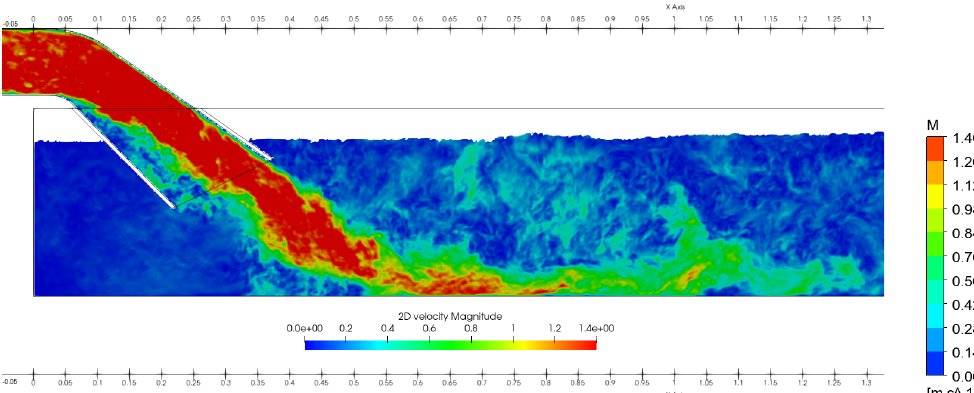
Figure 7. LBM, the magnitude of instant 2D velocity in vertical plane ( z = 0mm) and time t = 20s. The unsteady results obtained with LBM have been time-averaged over the last 10 s of simulation time. The time-averaged velocity field is then compared with the time-averaged results obtained with the finite volume method and with the experiment. The results are presented in the form of the magnitude of time-averaged 2D velocity (i.e., M = (cid:112) + u 2 u 2 for vertical cuts and M = for horizontal cuts) and as integral curves of the 2D x z velocity